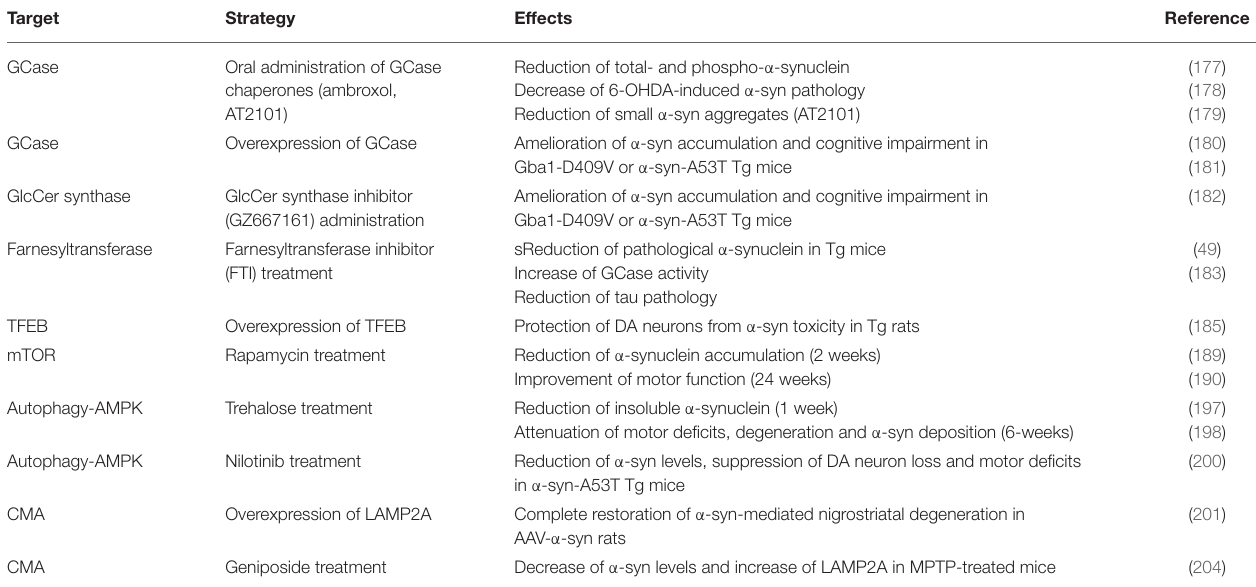
TABLE 1 | Strategies to enhance lysosomal activity for the modulation of PD-related phenotypes in vivo